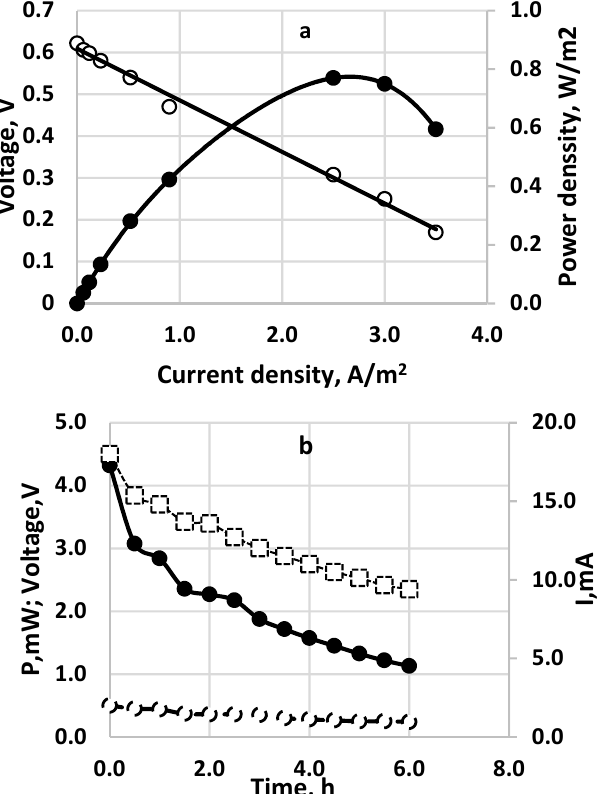
Figure 8. Electrochemical performance of sulfide-driven fuel cell. Active electrode and membrane area—100 cm 2 each. Inlet sulfide concentration—257 mg dm − 3 . Flow rate 20 cm 3 /h. Anode space—40 cm 3 . Cathode space—60 cm − 3 packed with GAC. Membrane—Fumapem* FFA-3-PK-75. Temperature 20 °C. ( a ) Polarization curve for continuous operation. ( ○ ) cell voltage; (•)—power density; ( b ) Time profile for continuous operation SDFC. ( ○ ) cell voltage; (•)—power density; ( • )—current density.